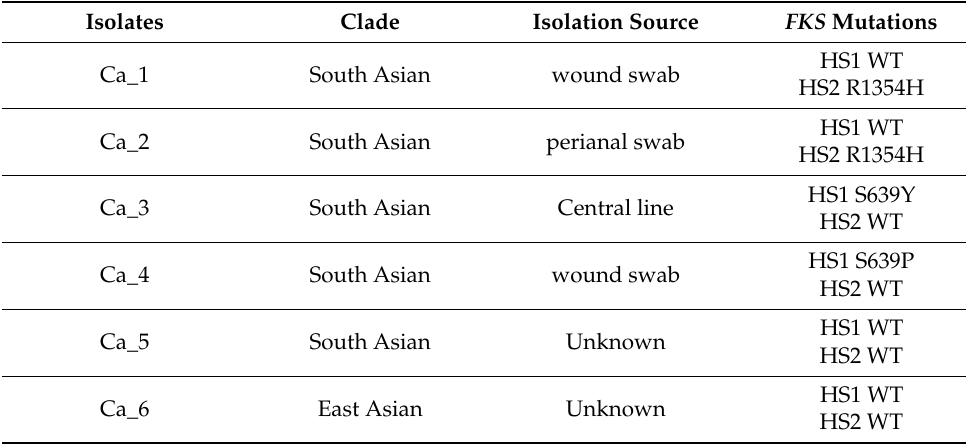
Table 1. Characteristics of Candida auris isolates used in this study. Isolates